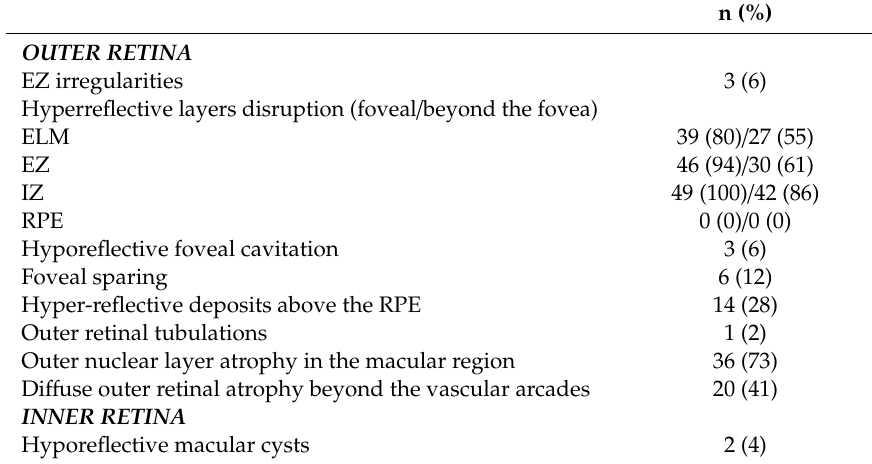
Table 3. Spectral-domain optical coherence tomography (SD-OCT) abnormalities (N = 49